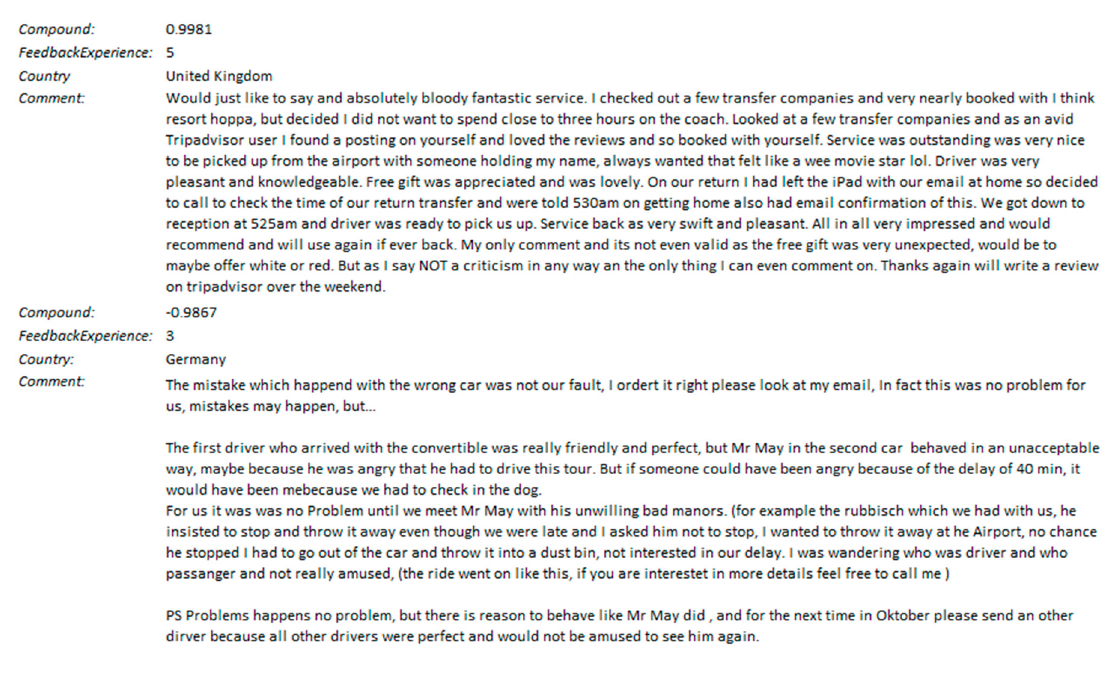
Figure 5. The most positive and negative sentiments associated with a